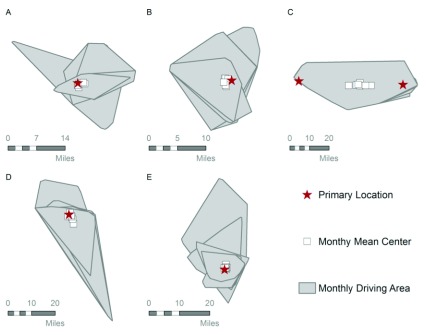
Spatial profiles.